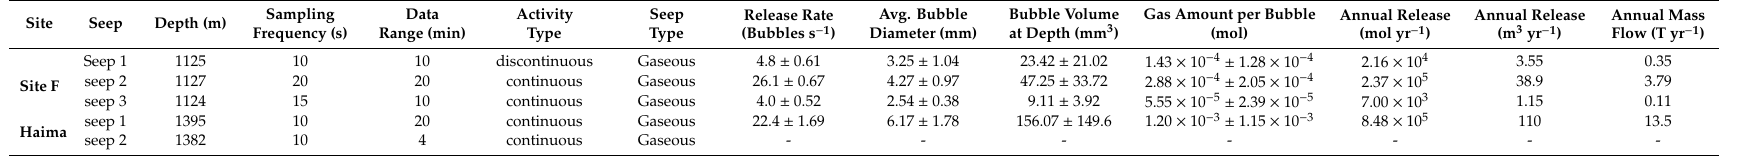
Table 1. Summary of cold seep sites, video samples, measurement results, and seep flow rate estimates for individual imaging